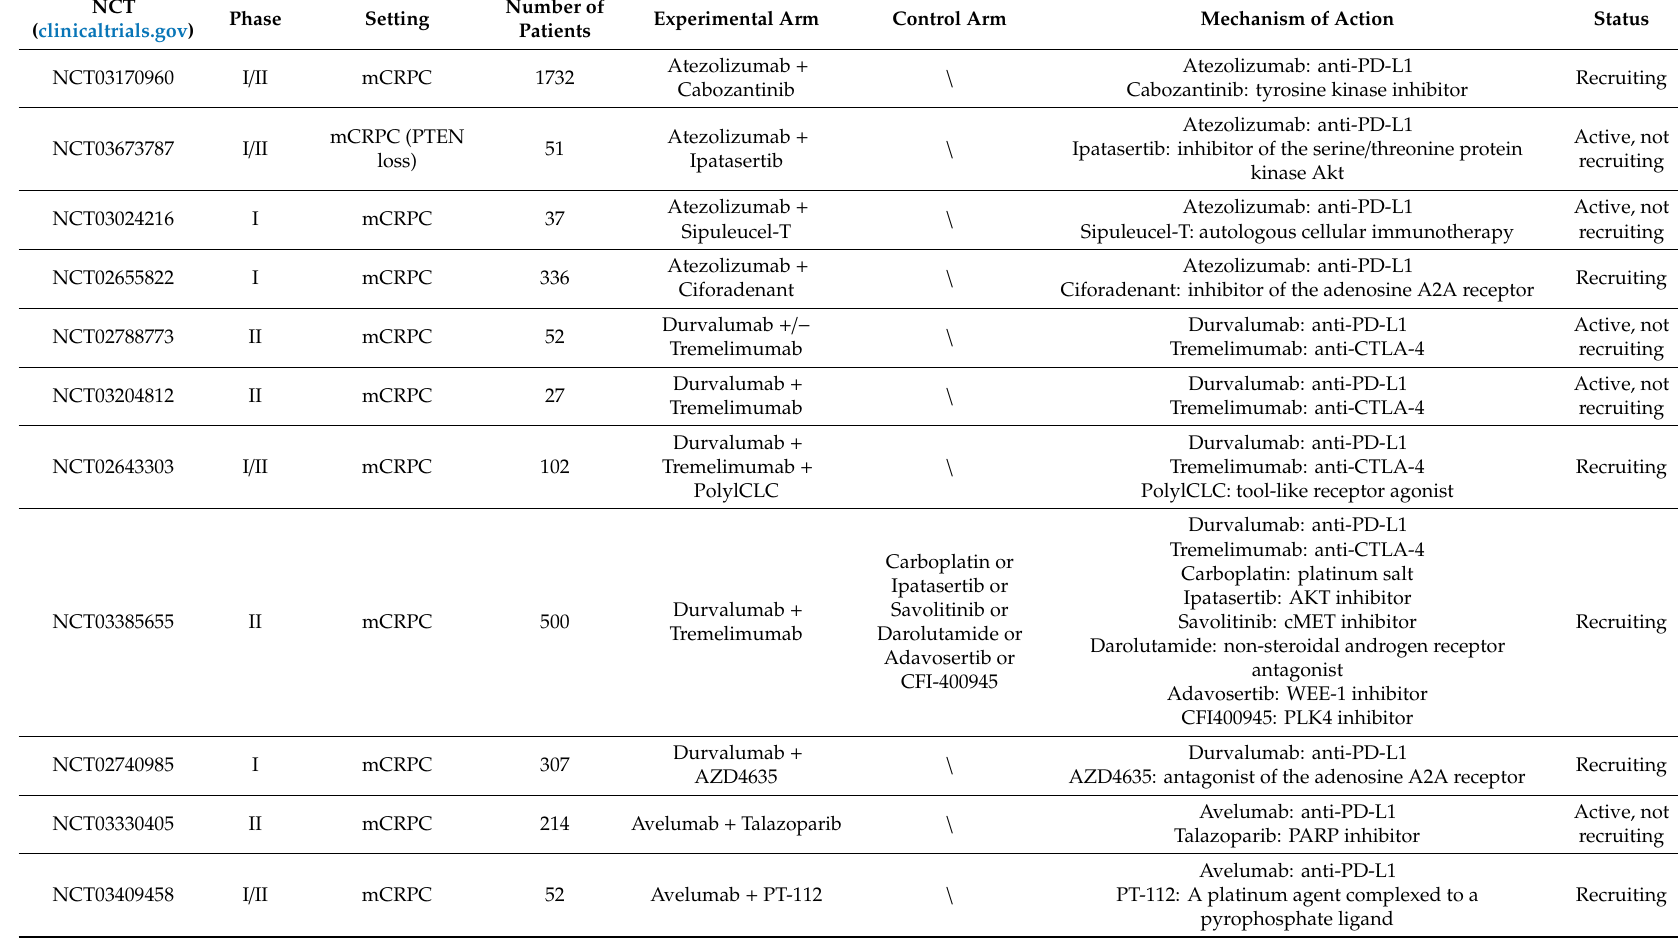
Table 1. Ongoing clinical trials of immunotherapy in prostate